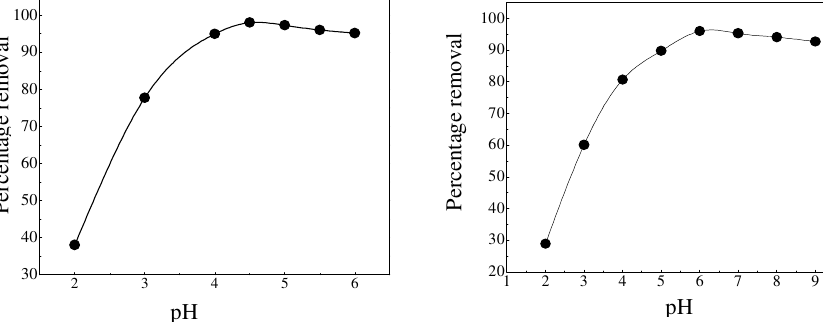
Figure 2. Effect of pH on the removal of Hg(II) ions on CSC (Initial Concentration- 10 mg L -1